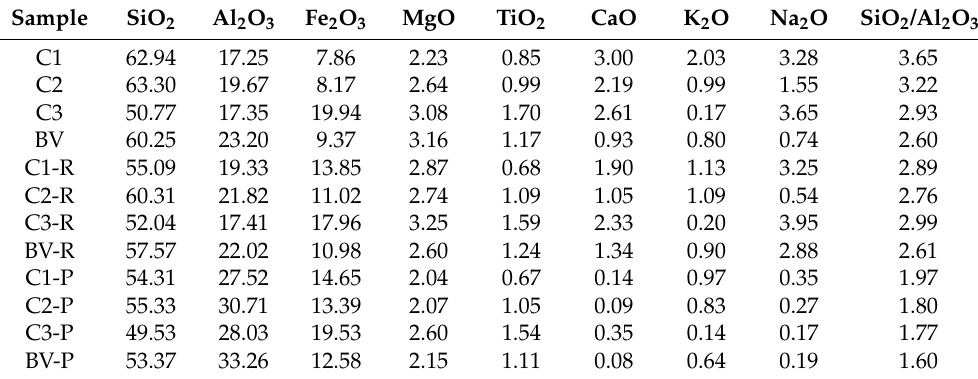
Table 1. Chemical composition normalized to the content of SiO 2 in the starting aluminosilicates ( w / w %) and SiO 2 /Al 2 O 3 mass ratio in raw minerals, starting clays and pillared materials.